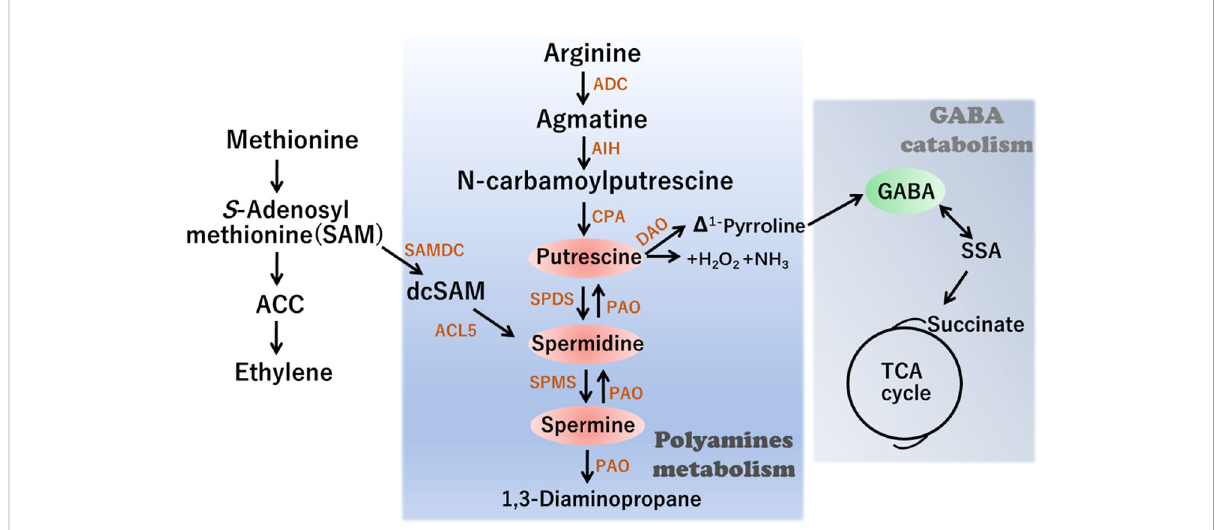
FIGURE 1 Schematic representation of Polyamines (PAs) metabolism and interconnection with g -aminobutiric acid (GABA) synthesis. ADC, arginine decarboxylase; AIH, agmatine iminohydrolase; CPA, N-carbamoylputrescine amidohydrolase; DAOdiamine oxidase; PAO polyamine oxidase; SPDS, SPDS, spermidine synthase; SPMS, spermine synthase; ACL5, ACAULIS5; SAMDC, S-adenosylmethionine decarboxylase; ACC, 1-amino-